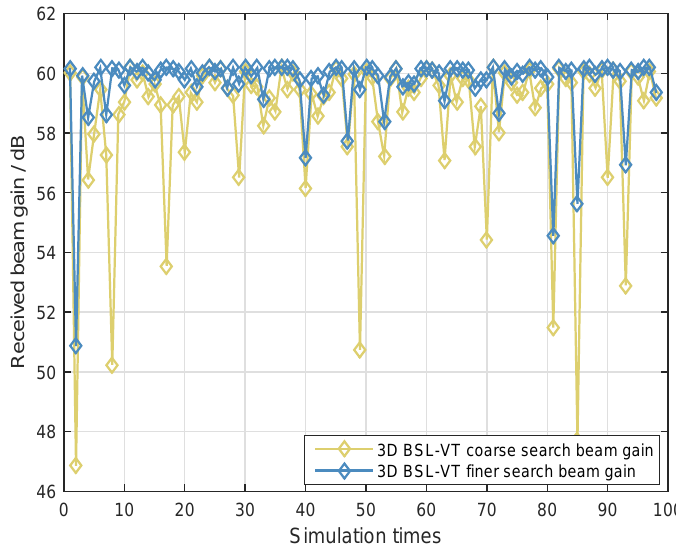
Figure 6. Maximum beamforming gain obtained by primary search and auxiliary